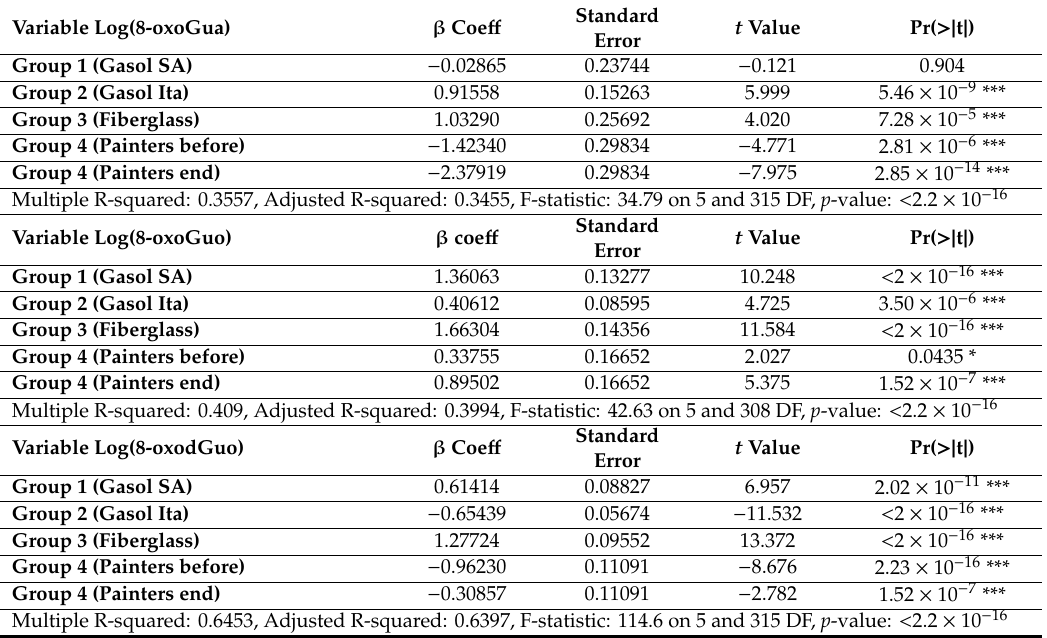
Table 5. Linear regression model results for the three oxidative stress